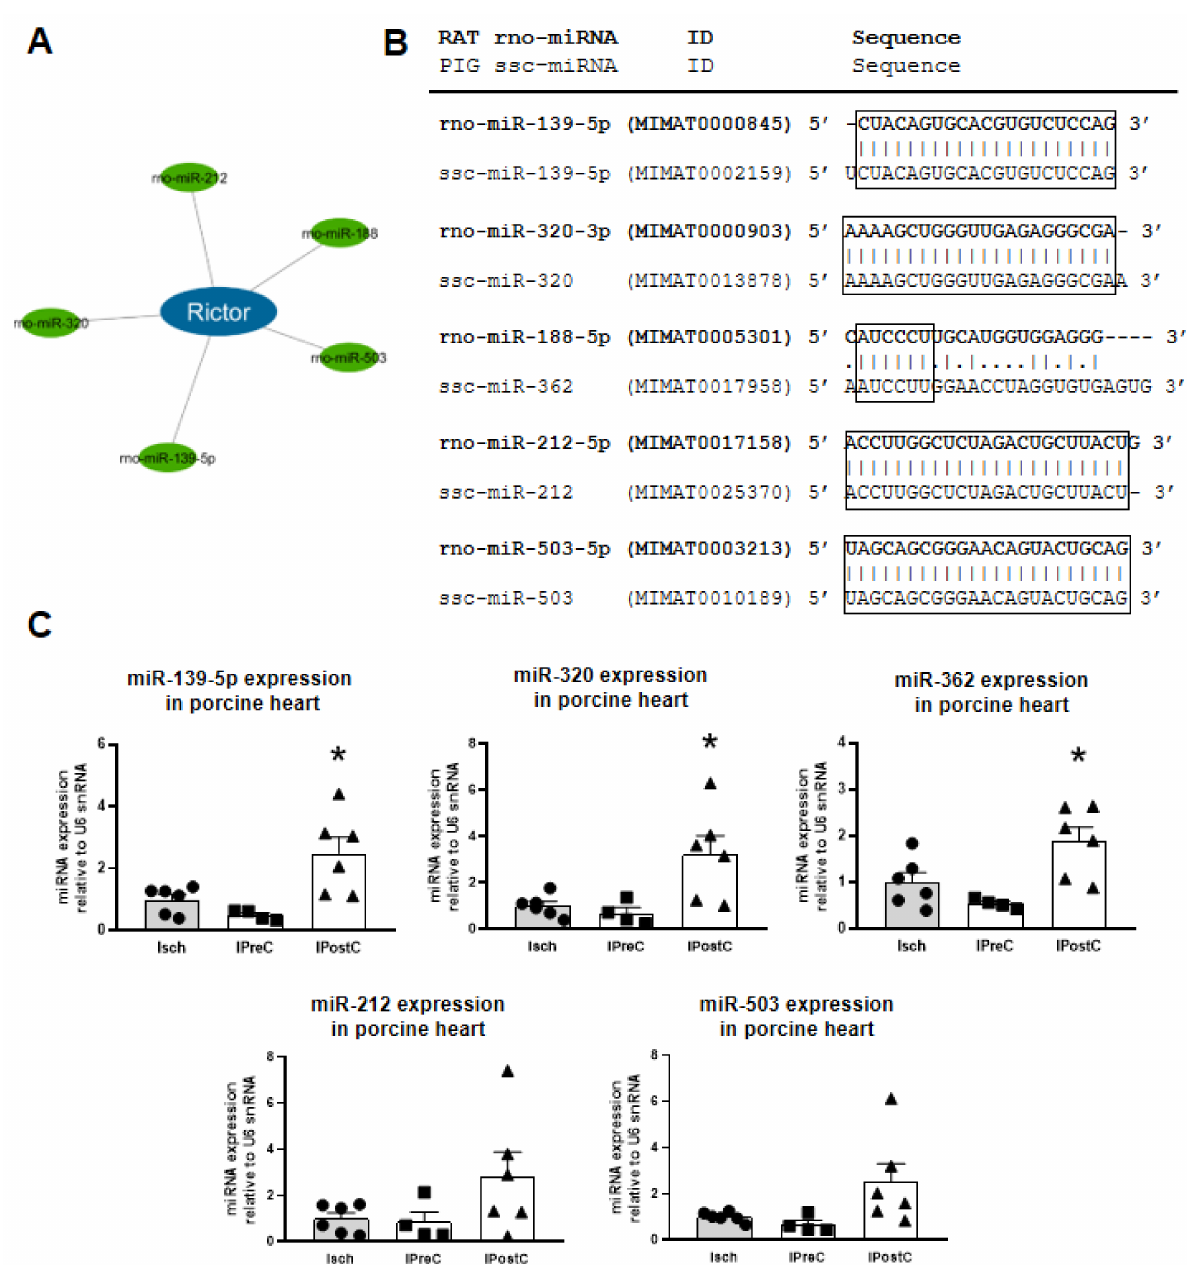
Figure 3. Pig homologues of the Rictor targeting microRNAs ( A ) were identified based on rat–pig microRNA sequence similarity. Four of the five rat microRNAs (miR-139-5p, miR-320, miR-212, miR-503) showed a 100% match and one (rno-miR-188-5p vs miR-362) showed a 56% match between pig and rat microRNA homologues ( B ). Expression levels of the five Rictor targeting ProtectomiR microRNA homologues were tested with qPCR in ischemic preconditioning and postconditioning compared to ischemia-reperfusion ( C ). Black circle, triangle and square signs represent individual data points. * p < 0.05 vs. Isch group, n = 4–6, one-way ANOVA followed by Dunnett post-hoc